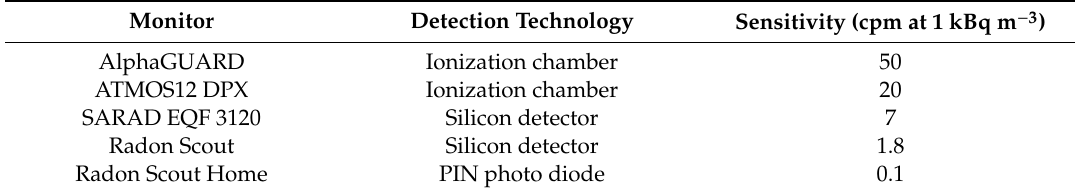
Table 4. Active monitor features used in the